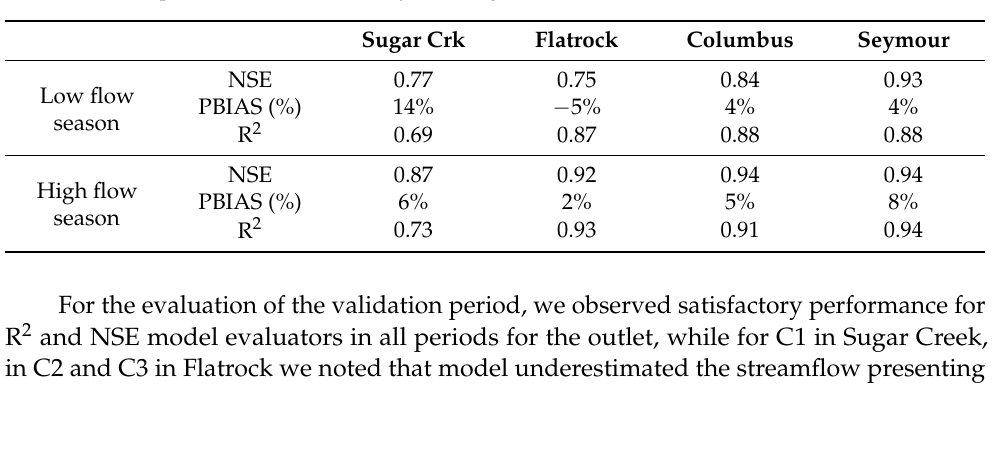
Table 4. Model performance for low (dry) and high (wet) flow